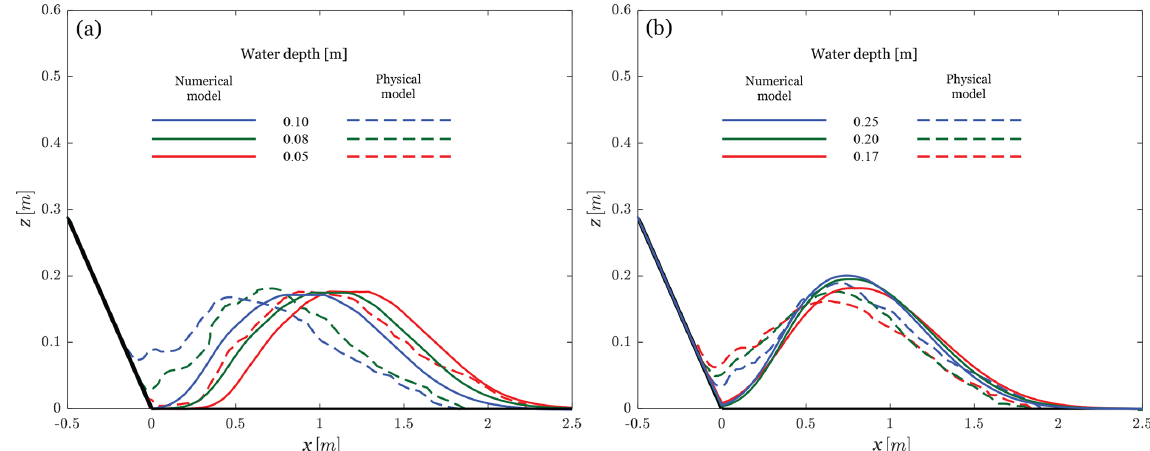
Figure 7. Cross section of the granular flow deposit for different still-water depths h (0.05 to 0.25m) (modified from Miller et al., 2017).